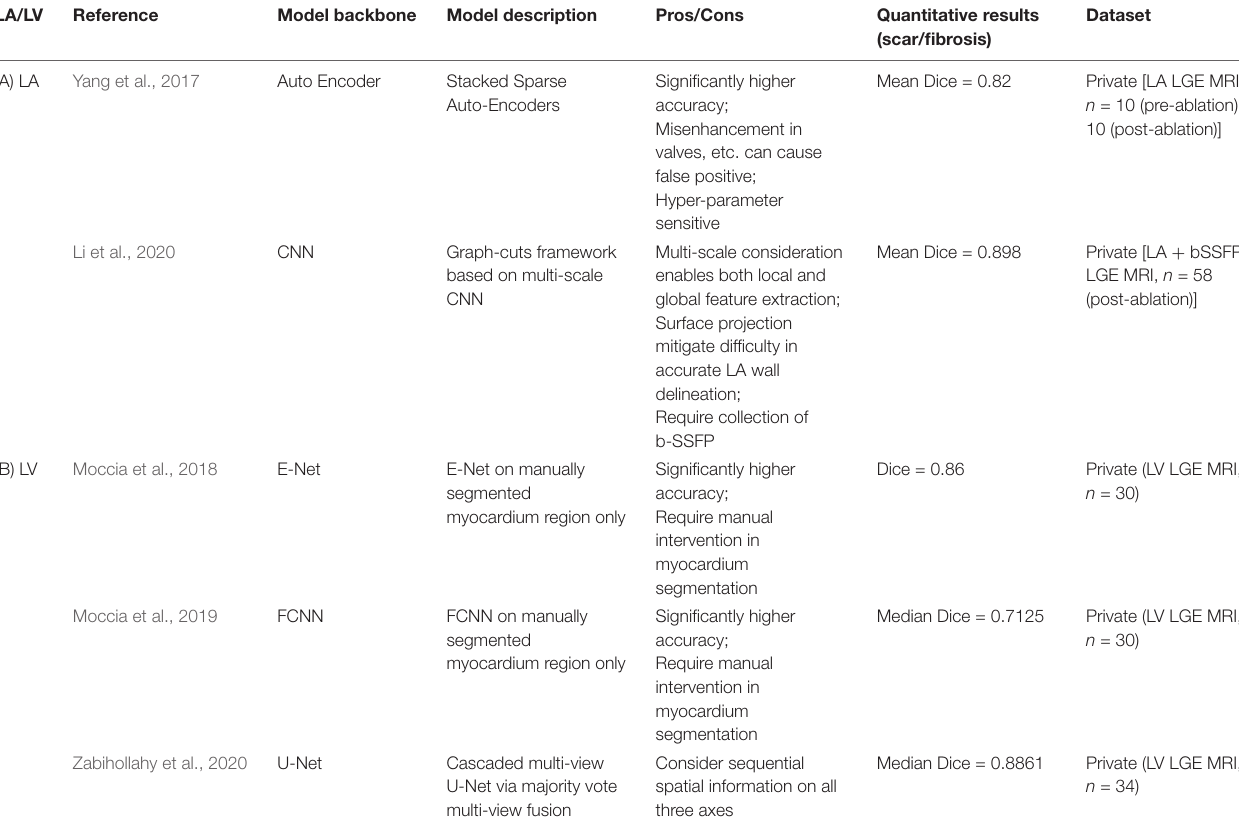
TABLE 5 | Summary of representative deep learning based methodologies for segmentation of cardiac scar and fibrosis regions on